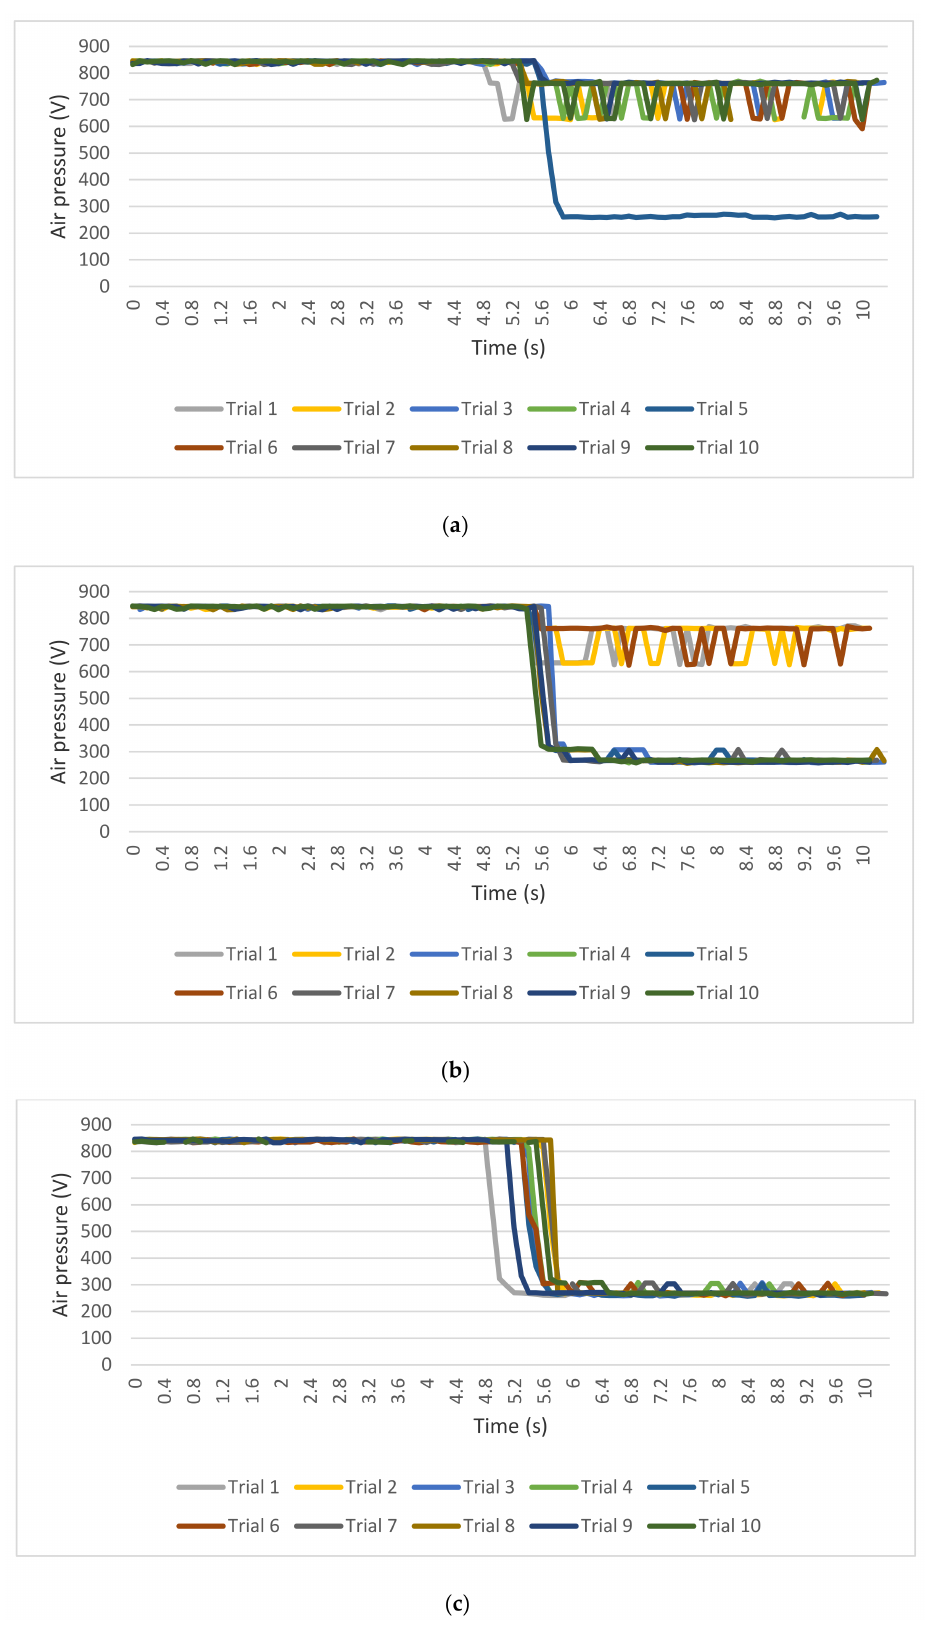
Figure 8. Collected air pressure signals depending on the z-position (during pick-up operation with box type II): z-position is set as ( a ) − 1 mm; ( b ) − 1.5 mm; and ( c ) − 2.0